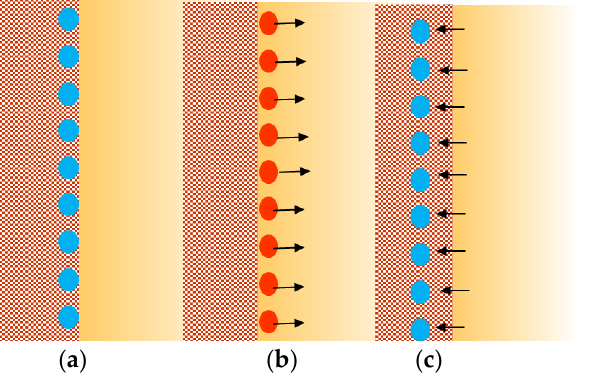
Figure 2. ( a ) Moisture adsorption on the paper surface; ( b ) Diffusion of oil/moisture aqueous solu- tion into the paper at low temperatures; ( c ) Moisture migration into oil at higher temperatures.